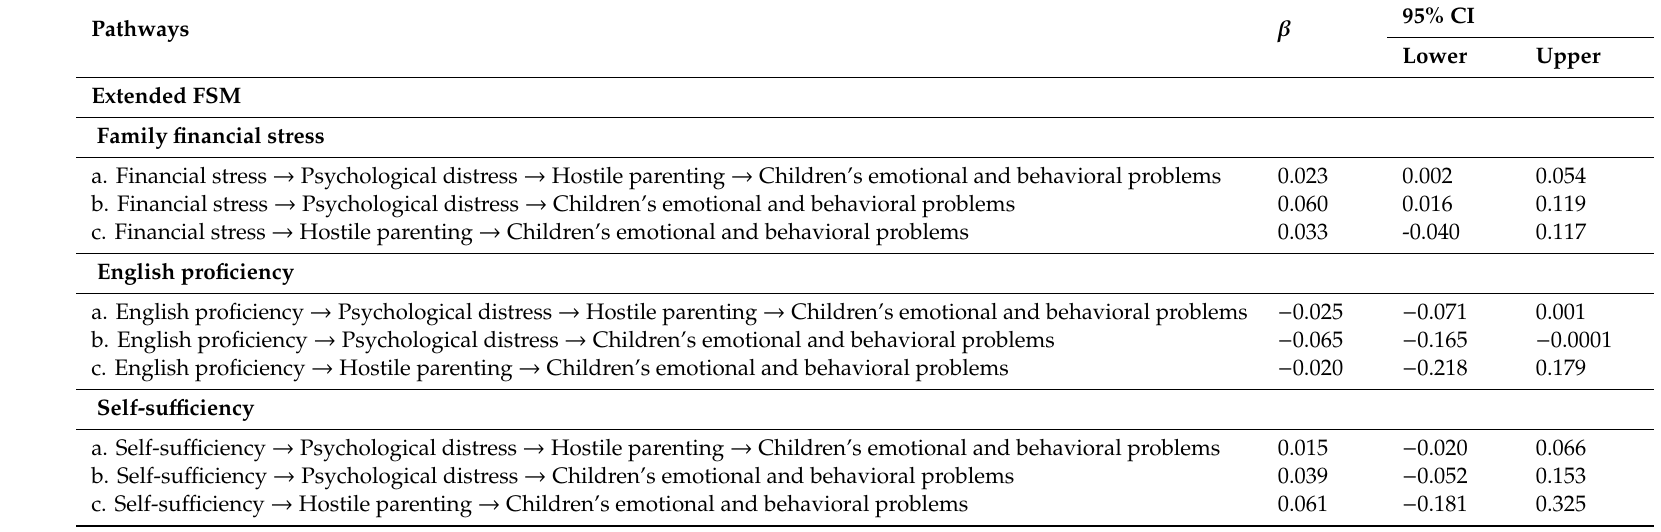
Table A3. The indirect e ff ects of financial stress, English proficiency, self-su ffi ciency, social interaction, and self-identity on children’s emotional and behavioral problems in the